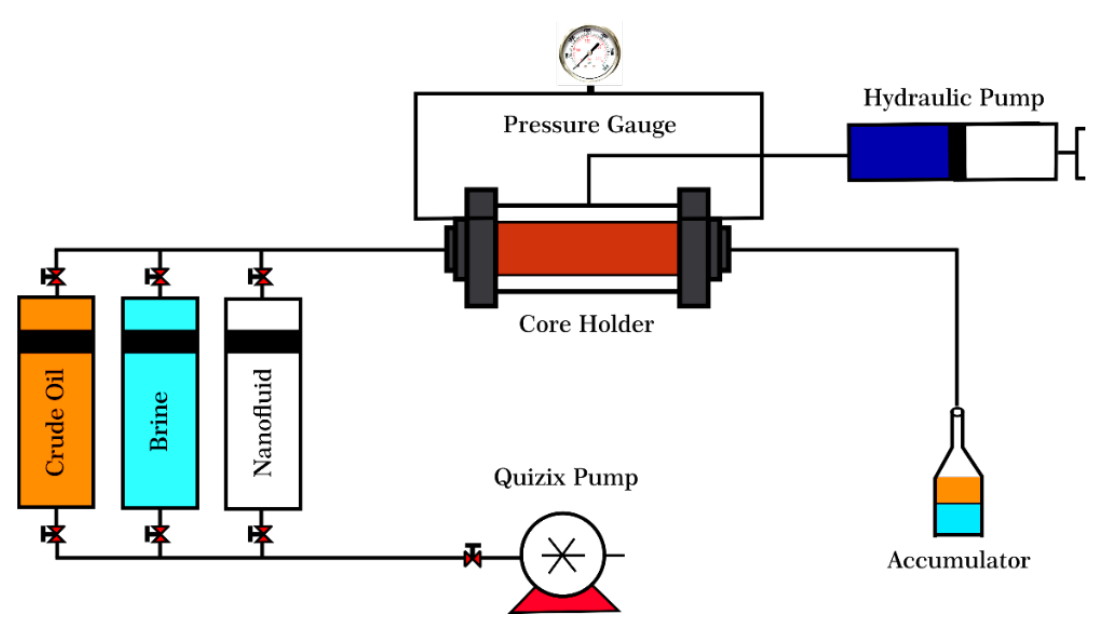
Figure 5. A schematic illustration of the core flooding setup.